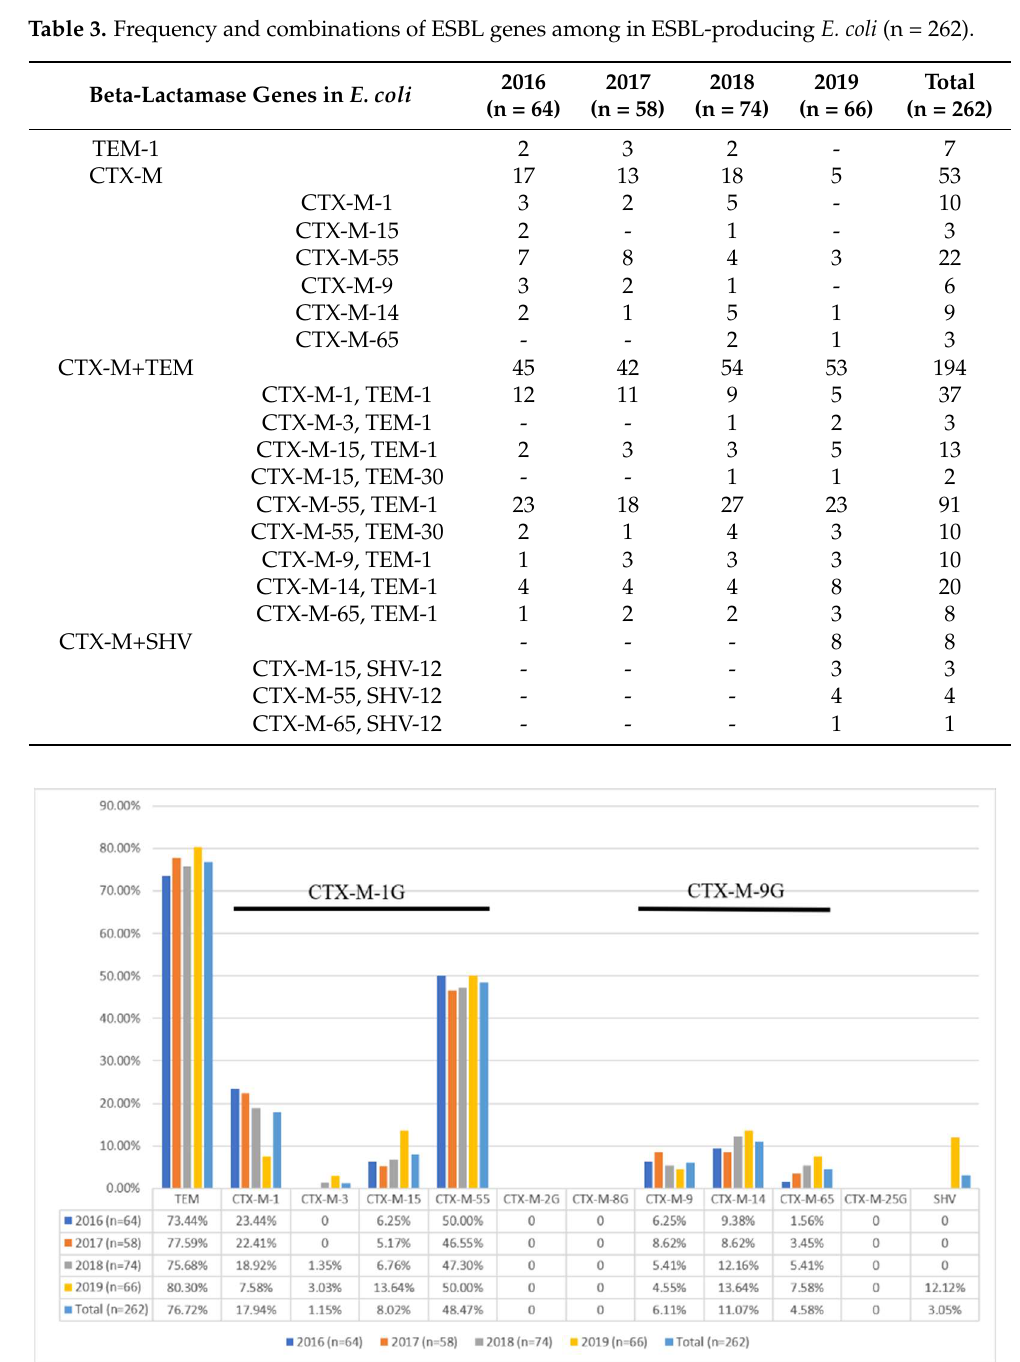
Figure 2. Percentage of ESBL subtypes in ESBL-producing E. coli isolates from chicken feces samples (n = 262). Table 3. Frequency and combinations of ESBL genes among in ESBL-producing E. coli (n = 262).